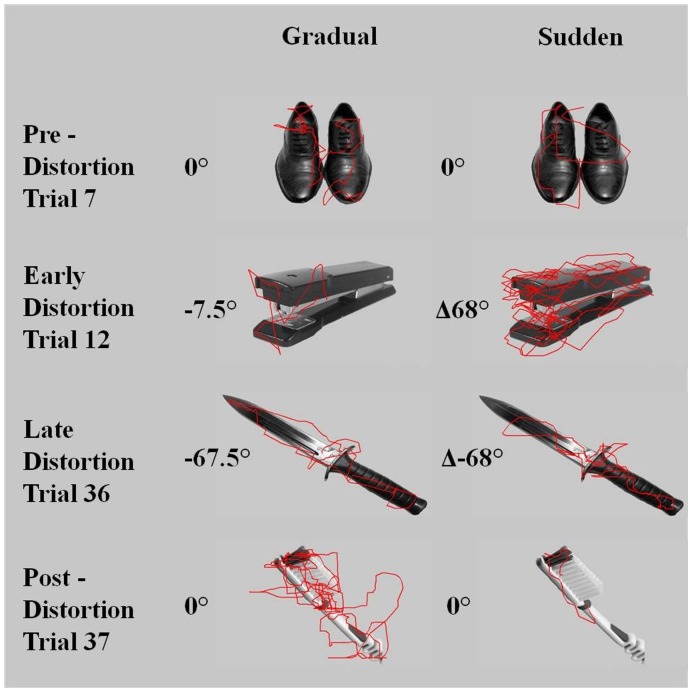
Sample scan paths from representative participants.A) gradual rotation group and B) sudden rotation group. The line represents the pathway of the viewing window from image onset until participant signal of image identification.